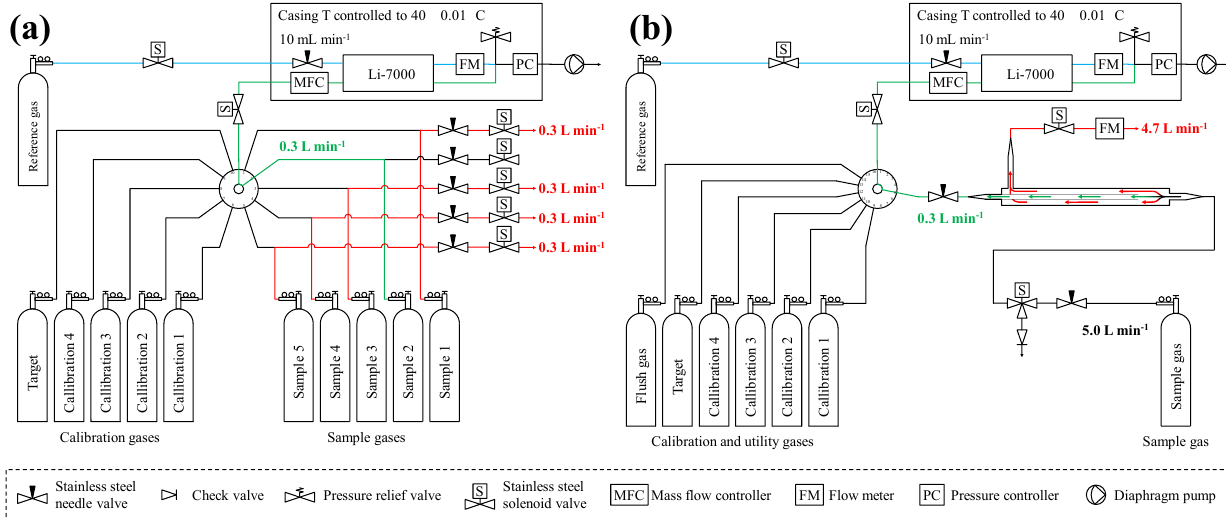
Figure 1. Schematic of the low-flow measurements system setup with the 10-port VICI valve (a) and the high-flow measurement system setup with the 16-port VICI valve (b) . The red lines and numbers indicate the gas that is drained to the room to maintain a steady flow out of the cylinder, the green lines and numbers are what goes into the analyzer, and the blue lines are the reference gas flow.